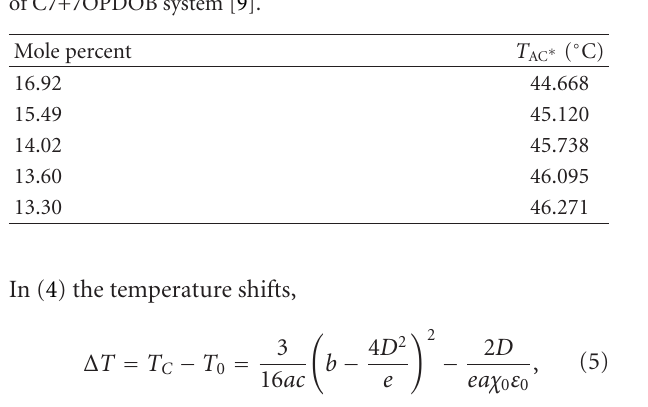
Figure 1: Tilt angle θ as a function of T − T C for the AC ∗ transition in a mixture of 70PDOB+C7 near the tricritical point ( X = 16 . 92) according to (4) with the P 2 θ 2 coupling.